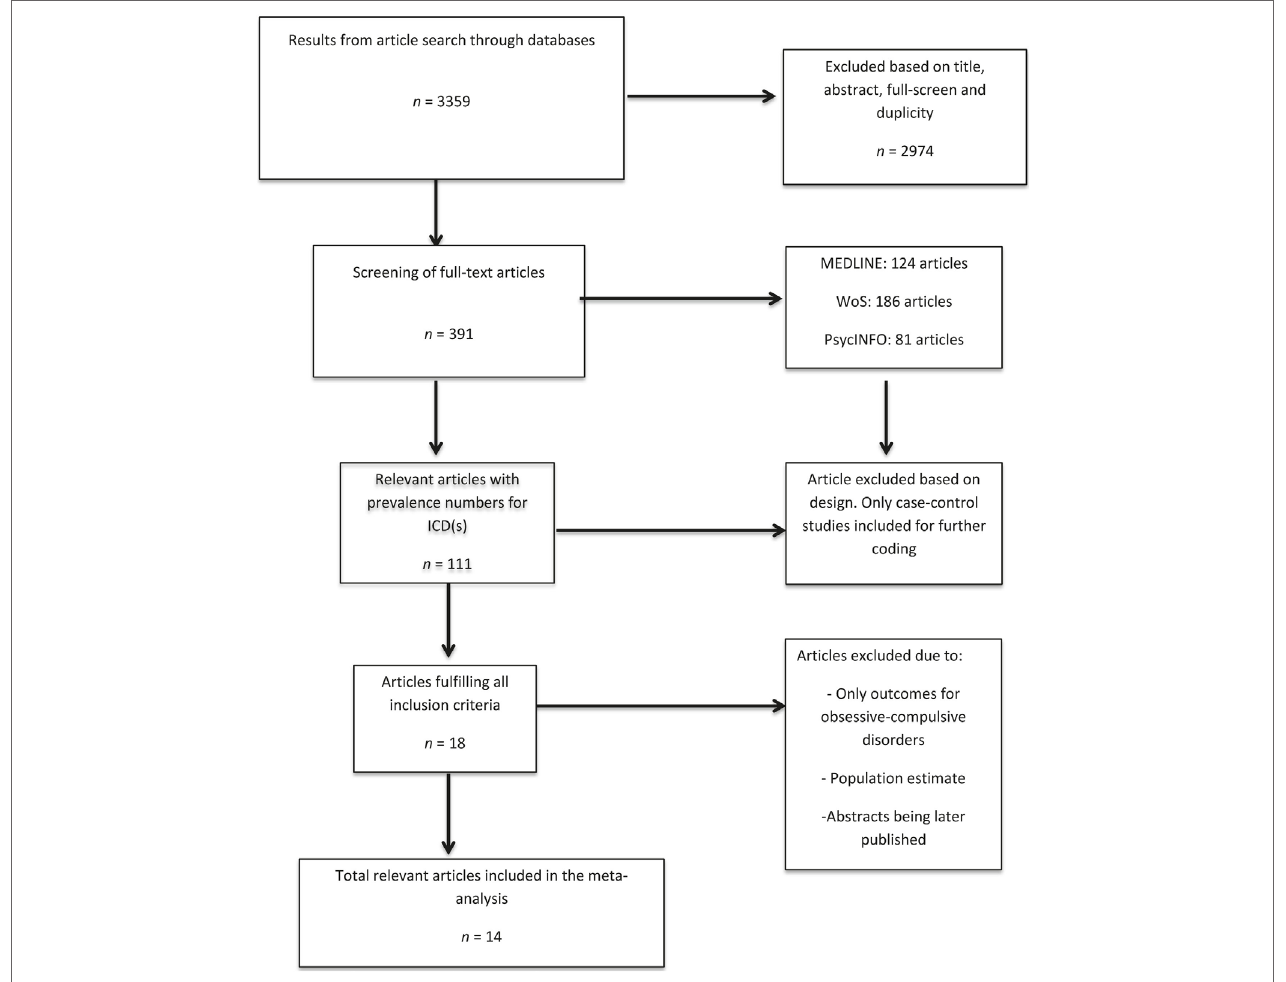
FigURe 1 | Flow diagram of literature